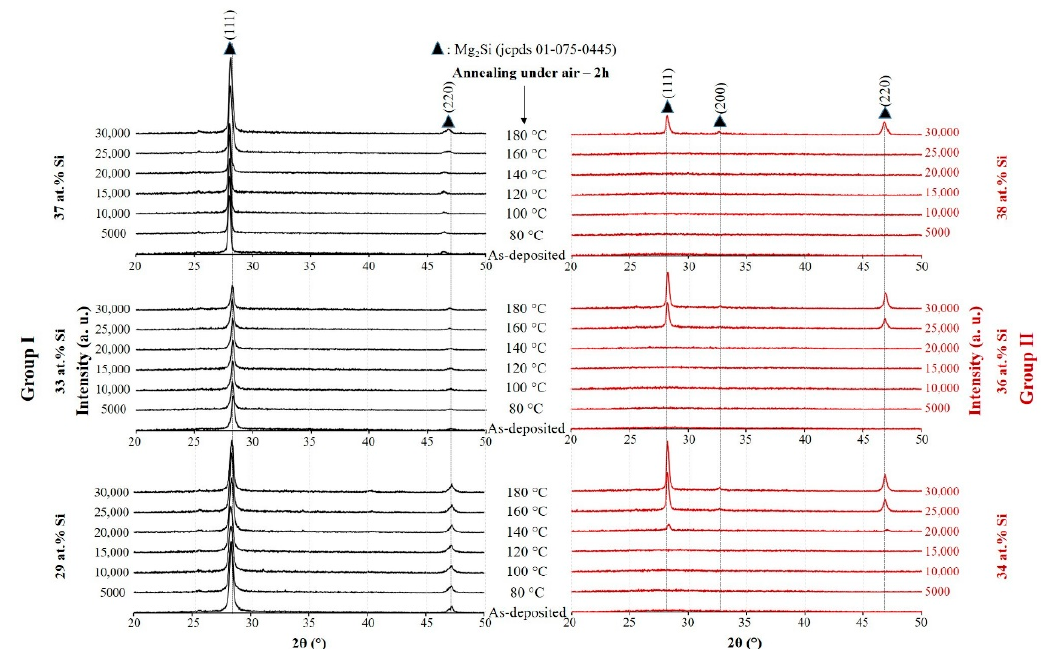
Figure 3. X-ray diffraction patterns of the films deposited on glass substrate after annealing in air for 2 h at different temperatures. (Group I: R P < 7 × 10 − 4 Pa and Group II: R P ≥ 7 × 10 − 4 Pa).